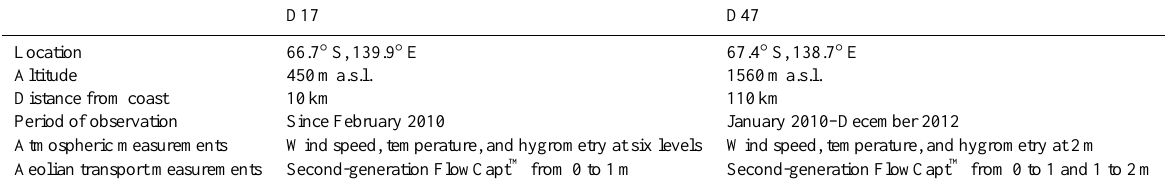
Wind speed, temperature, and hygrometry at six levels Wind speed, temperature, and hygrometry at 2m Aeolian transport measurements Second-generation FlowCapt ™ from 0 to 1m Second-generation FlowCapt ™ from 0 to 1 and 1 to